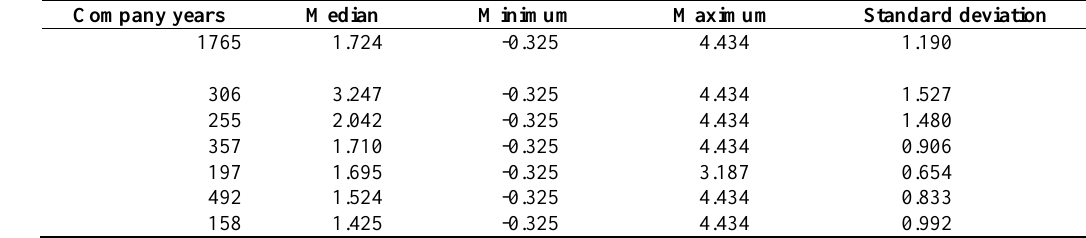
Table 1: Descriptive statistics per